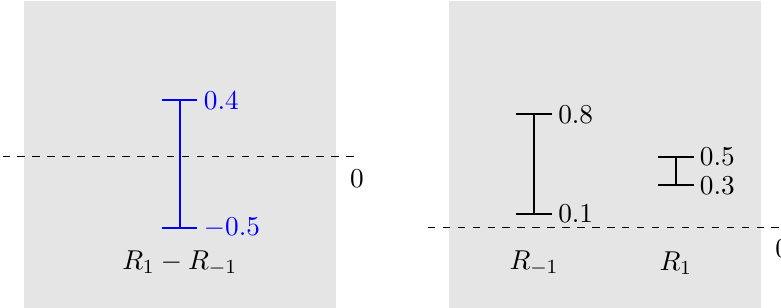
Figure 1. A toy example on slot machines. The left panel: the possible range of R − R ; the right panel: the possible ranges of R 1 − 1